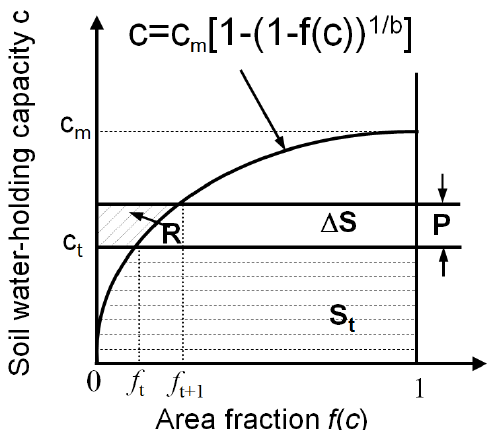
Figure 3. Distribution of soil water-holding capacity in a 0.5° latitude × 0.5° longitude grid